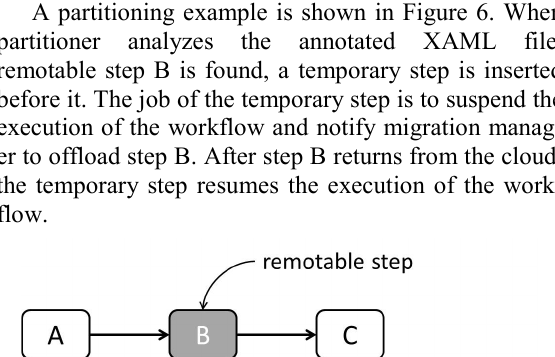
Figure 5: Given an annotated workflow as input, the Emerald partitioner outputs a modified workflow with migration points.